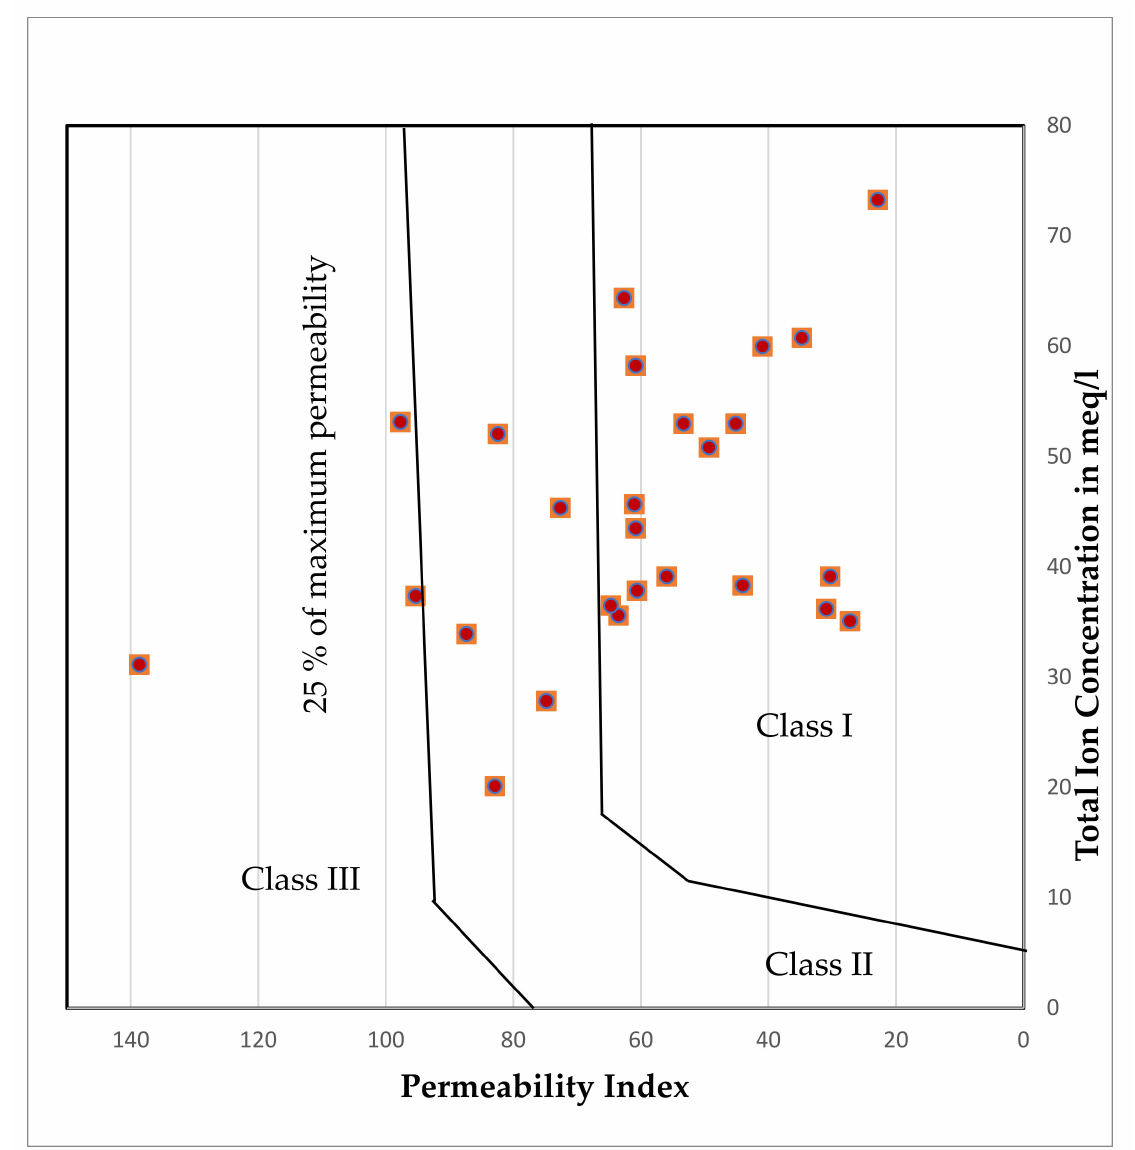
Figure 9. Doneen classification of irrigation water quality based on